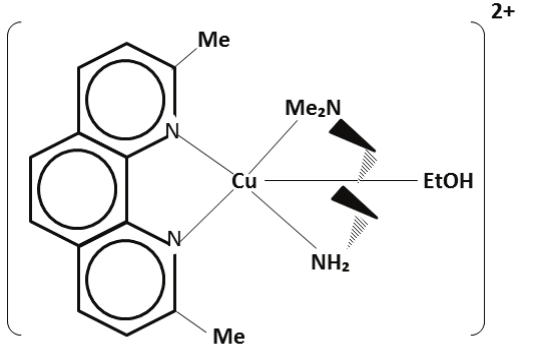
Figure 1. Structure of the [Cu(2,9-dimethyl-1,10-phenanthroline- N,N-dimethyltrimethylene-diamine)(EtOH)] (NO ) •2H O], 2 2 2